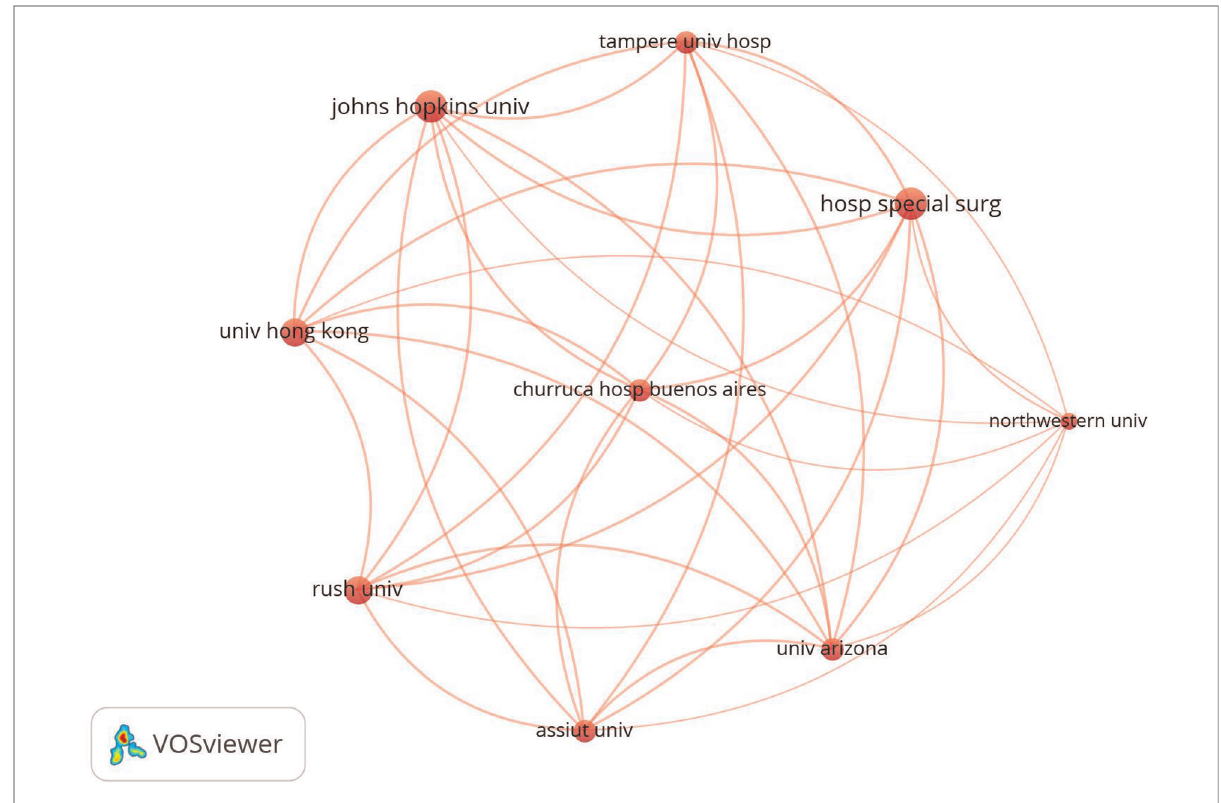
FIGURE 2 Co-operation network of productive institutions.